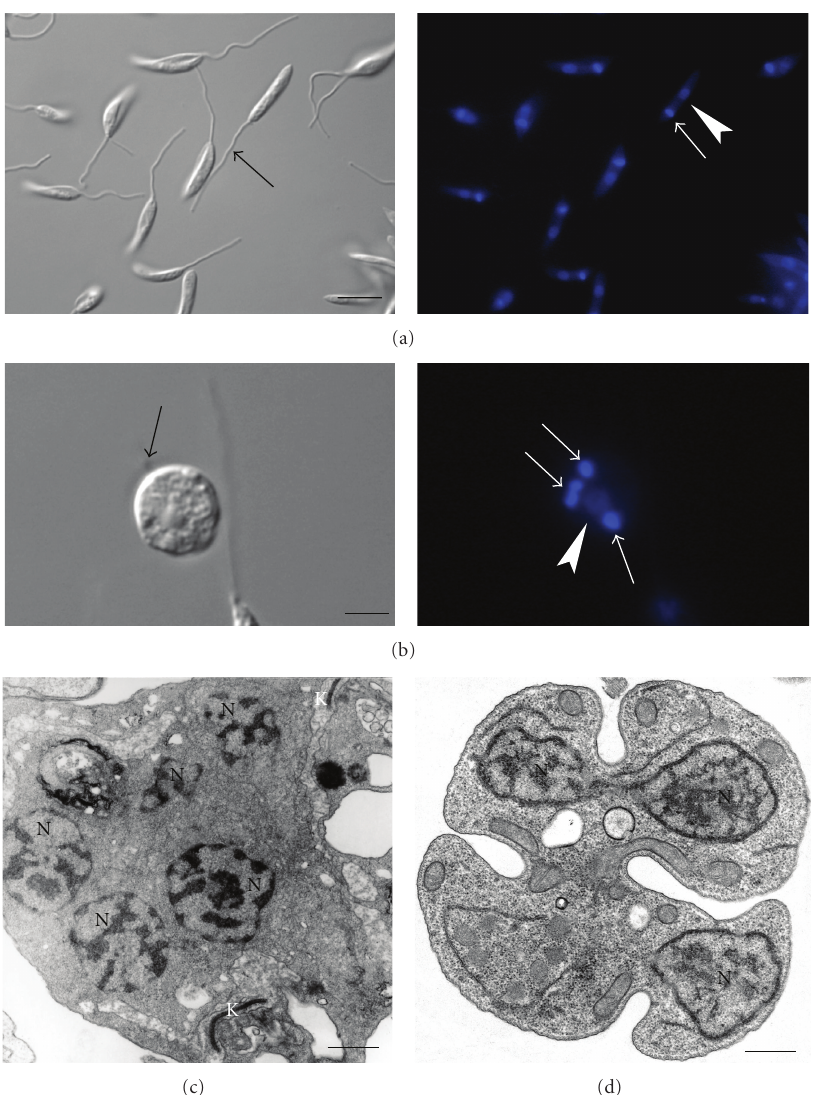
Figure 13: DIC microscopy ((a)-(b), left panel ), fluorescence with DAPI ((a)-(b), right panel ) and transmission electron microscopy (c)- (d) of treated-promastigotes to evidenciate the alterations in the cell cycle after treatment with BPQ-OH and ER-119884. (a) Control cells present a correct number of kinetoplast (white arrow), nucleus (arrowhead), and flagellum (black arrow), one of each for a unique cell. (b) After treatment, the number of these organelles is completely alterated and it is possible to find cells with one flagellum (black arrow), four kinetoplast (white arrows), and one nucleus (arrowhead). (c)-(d) Alterations in the cell cycle can also be evidenced by transmission electron microscopy with the appearance of cells with several nuclei and kinetoplasts. K, kinetoplast; N, nucleus. These images are reproduced with permission from [37] American Society for Microbiology (a), (b), (d), and from [66] Elsevier (c). Bars, 5 μ m (a)-(b), and 0 . 5 μ m